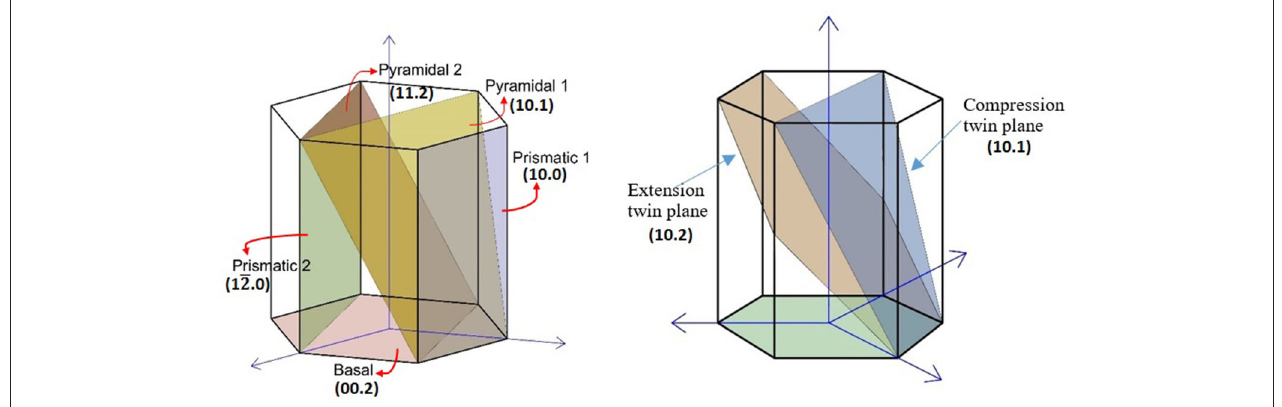
FIGURE 1 | Slip and twinning planes in magnesium